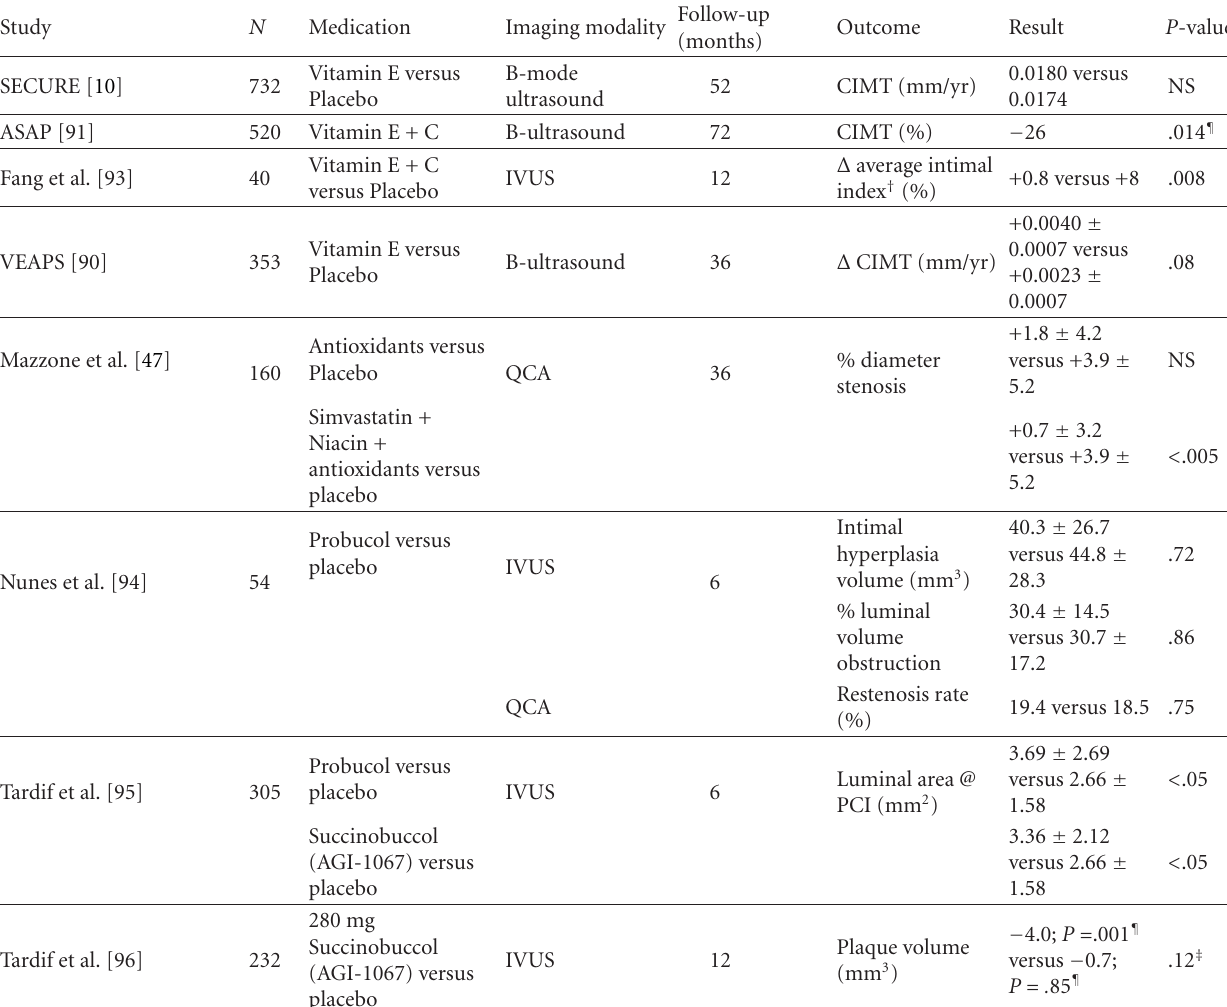
Table 3: Summary of trials highlighting the anti-atherosclerotic e ff ects of